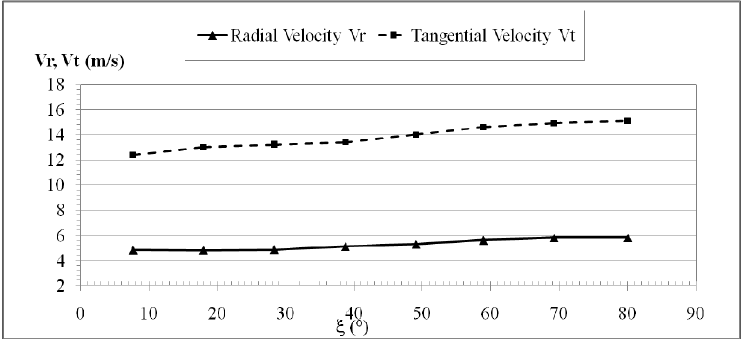
and the radial velocity V t